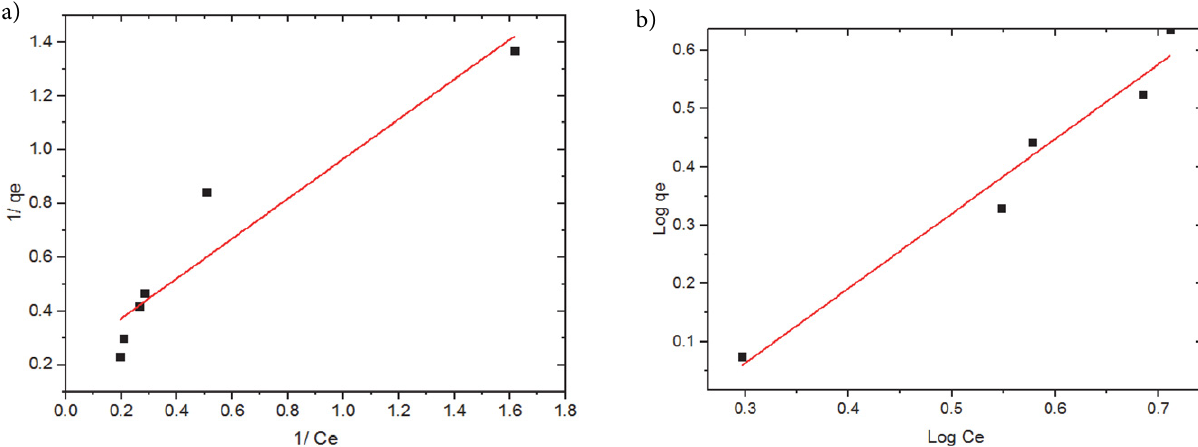
Figure 12. Langmuir curve of adsorption (a ) Freundlich curve of adsorption ( b)